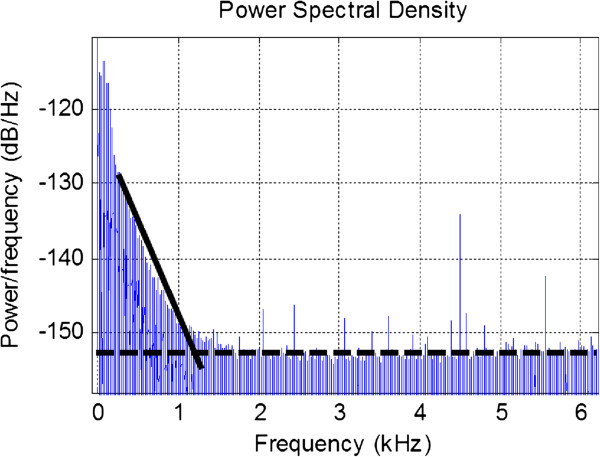
Power spectrum density of a 5 min long ECOG recording. The power axis is referenced to 1 Vrms.